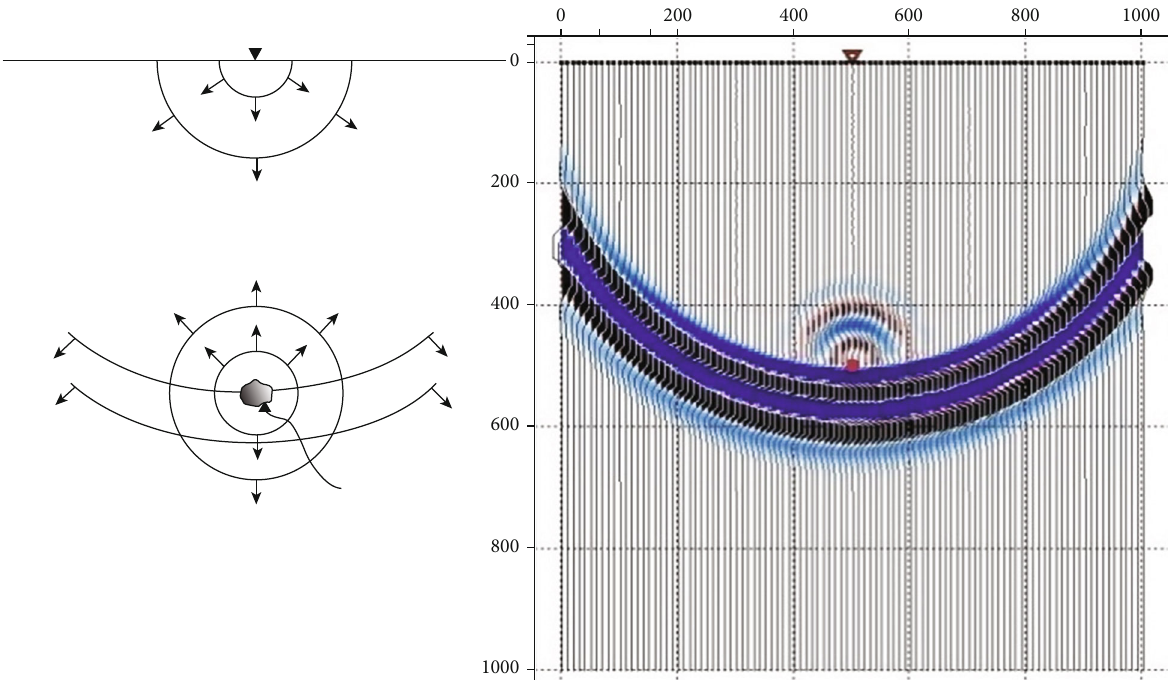
Figure 1: The generation of di ff racted wave (Li,